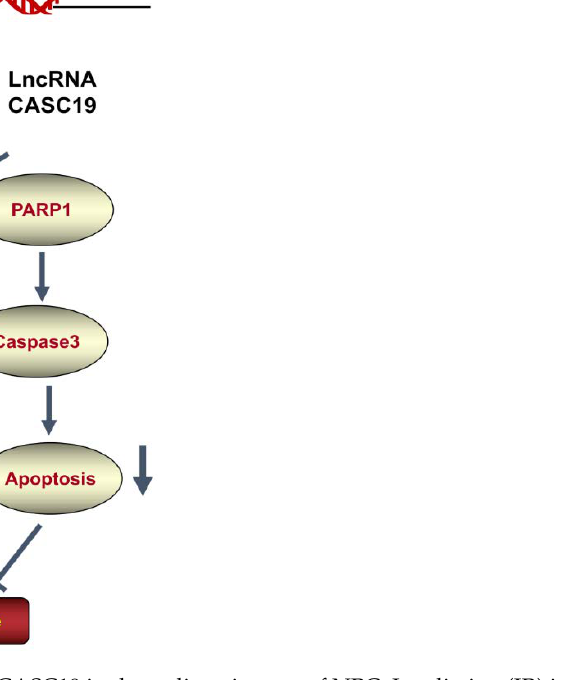
Figure 7. Regulation pathway of CASC19 in the radioresistance of NPC. Irradiation (IR) increased the expression of CASC19 in NPC cell lines. CASC19 contributes to autophagy via activating the AMPK/mTOR signaling pathway while inhibiting apoptosis by depressing PARP1 and cleaved- caspase3.